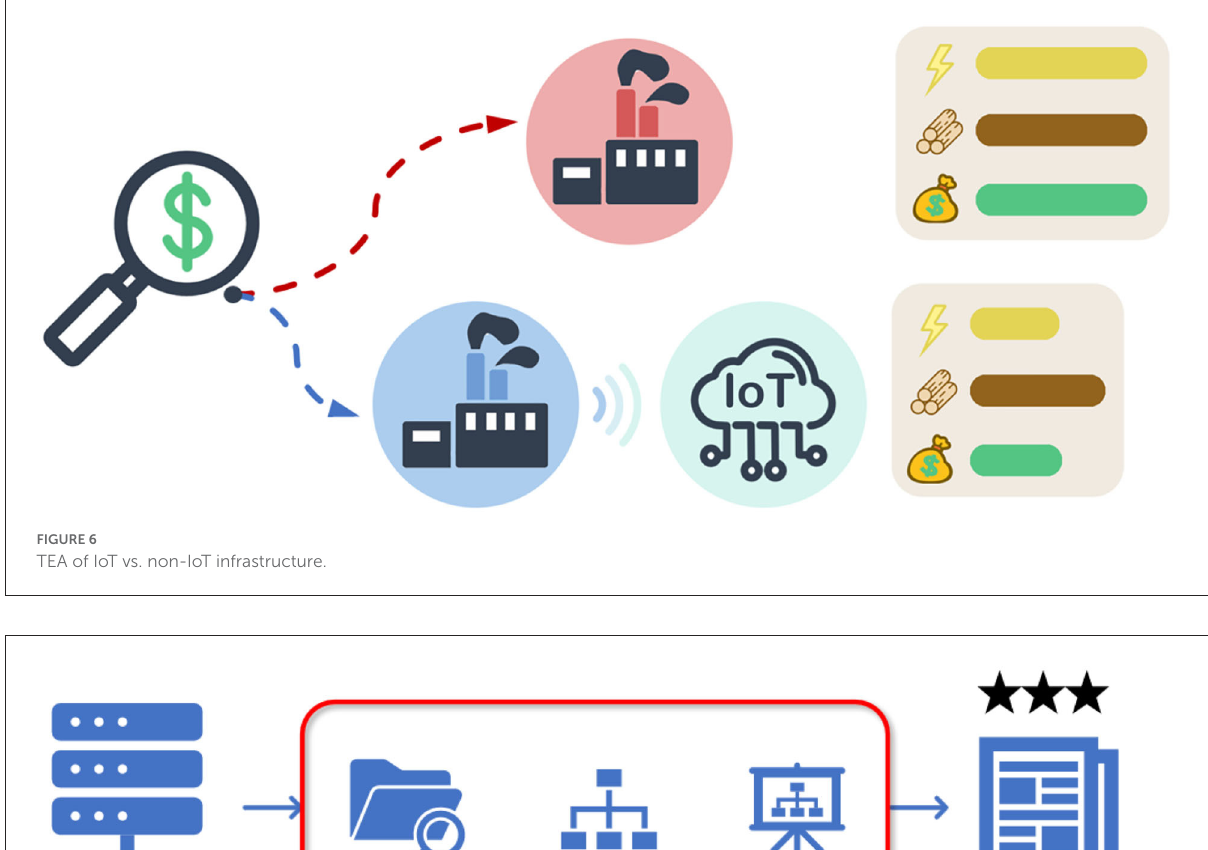
FIGURE7 Extraction of valuable information via big data